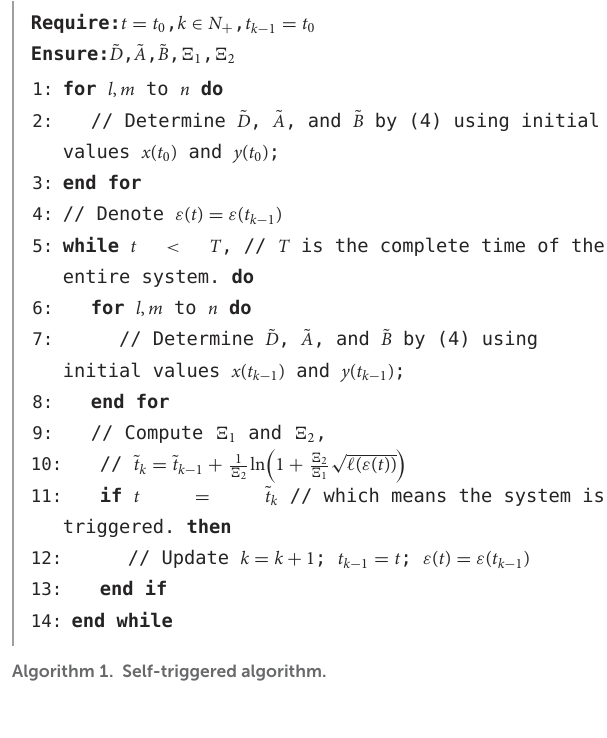
Algorithm 1. Self-triggered algorithm.